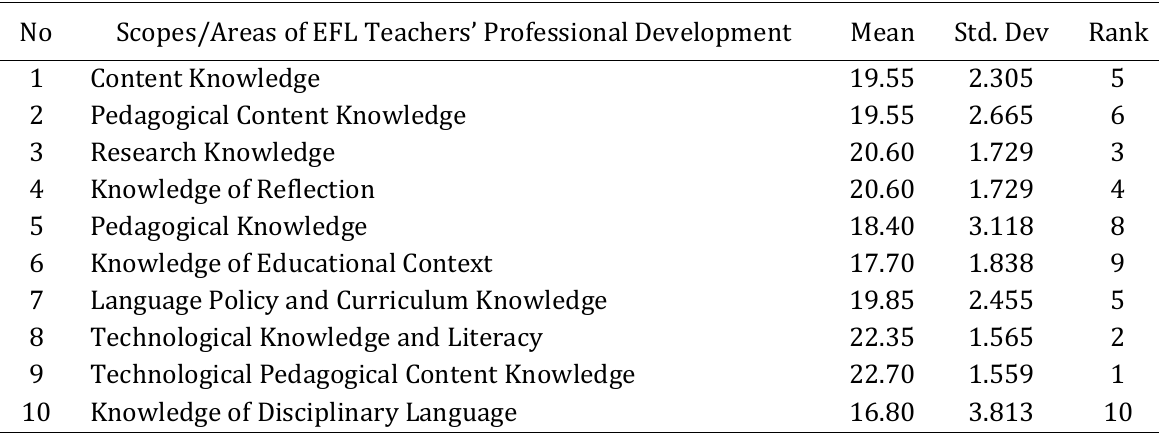
Table 2. Difficulty of EFL Teachers on EFL Teachers' Professional Development Scopes/Areas